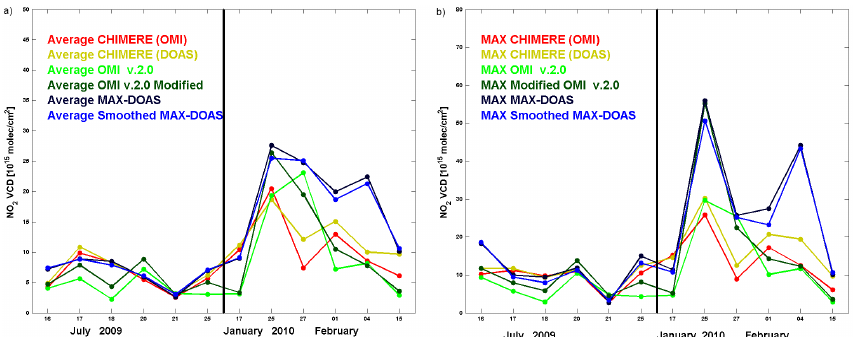
Figure 20. Comparison of the daily average (a) and maximum (b) tropospheric NO 2 VCDs for coincident data of all three data sets (car- MAX-DOAS measurements along large circles and OMI observations for CF<30%; rotated CHIMERE